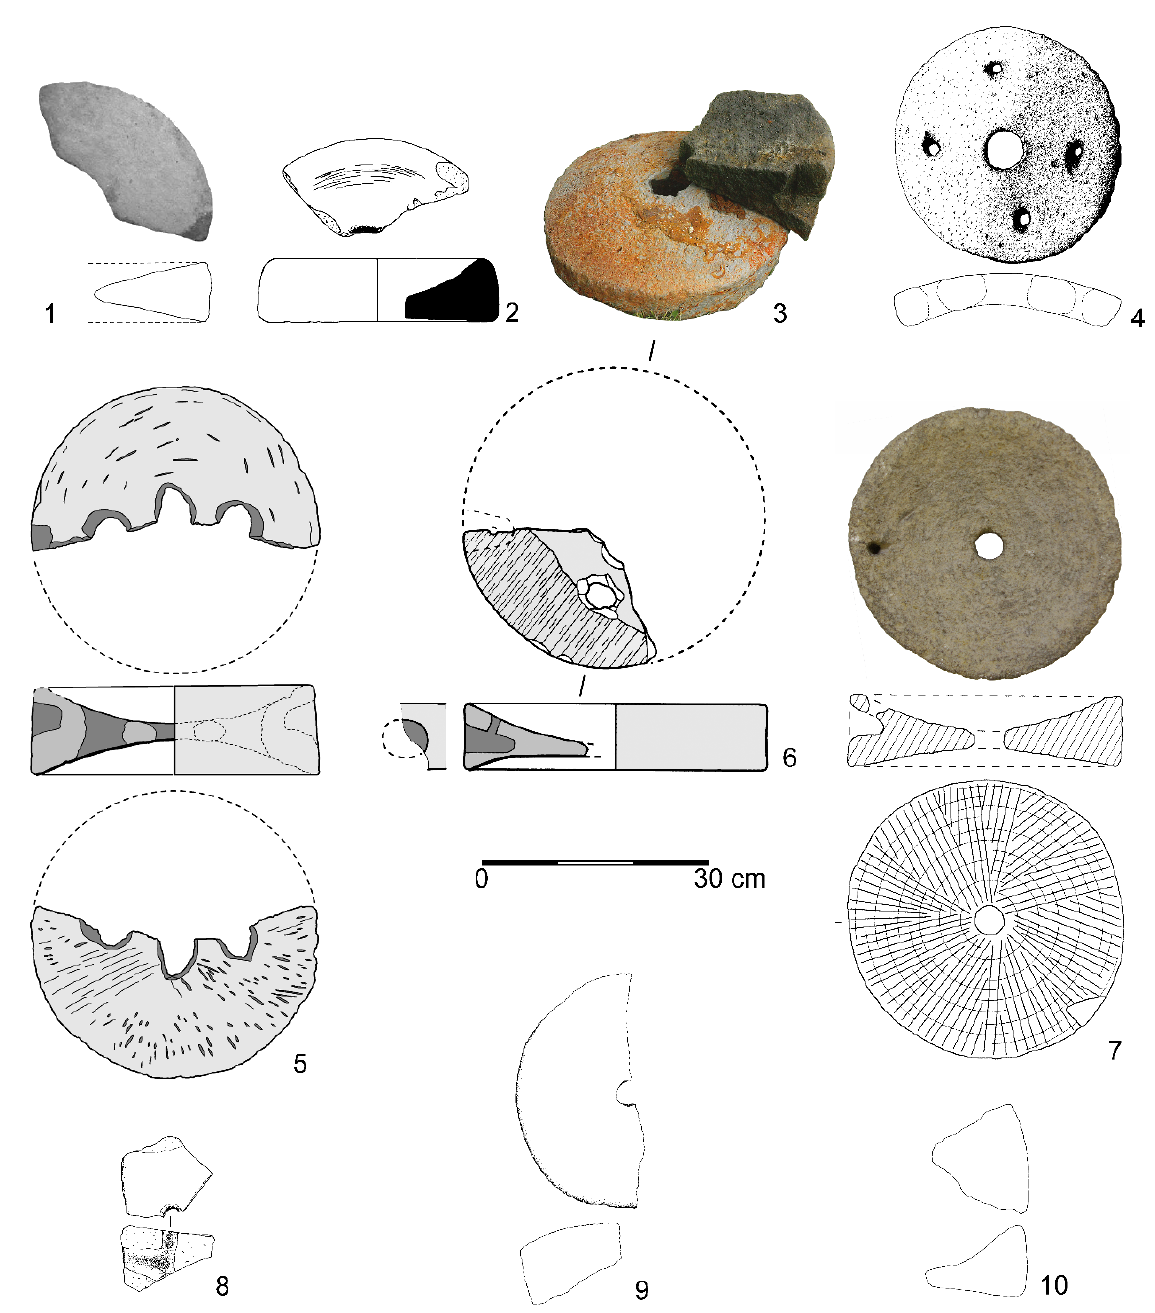
Figure 7. Quernstones of Brillerij type from Roman times. 1-2,5-8,10: upper stones; 3: upper and lower stone; 4,9: lower stones. Provenances: 1. Barkhausen; 2. Rödgen; 3. Inden-Altdorf; 4. Hedemünden; 5. Pommern and Karden, oppidum Martberg; 6. Metz, rue Paille-Maille; 7. Mayen, Brückenstraße; 8-9. Utrecht, Sportpark Terweide; 10. Nenndorf. (1. Schaaff 2010: fig. 2:3; 2. Simon 1961, fig. 2:40 a-b; 3. Geilenbrügge & Schürmann 2010: fig. 69; 4. Wefers 2012b: pl. 63; 6 Asselin et al . 2017: fig. 2:3; 7. Wefers 2012a: pl. 102:548; 8-9. Mooren 2009: fig. 6:254.255; 10. Kreibig 2006: pl. 23:339.8). From layers of the period from about 30-40 to 60-70 CE comes the fragment of a runner (Figure 8:1) from the Kastelen plateau at Augst in Switzerland (List, 2). Its lack of a broad rim is in common with the catilli of Brillerij type. However, both the upper surface and the grinding face have a straight course, according to the